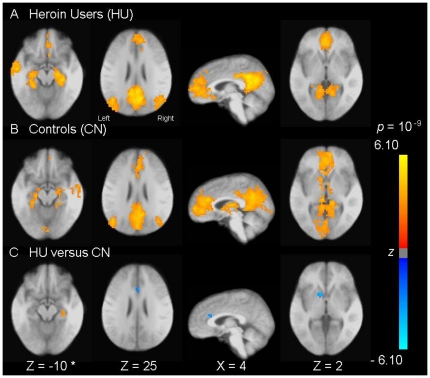
Altered Functional Connectivity of the Default-Mode Network in Heroin Users.Images of group default-mode functional connectivity in heroin users (HU; A) and in non-addicted controls (CN; B). The contrast map in panel C demonstrates clusters (see Table 1) where resting-state functional connectivity in the DMN was altered in HU versus CN. Clusters above thresholds (p<0.05, corrected) in t-tests were lightened with z-scores converted from t-scores of these tests. The z-score bar is shown right side of the figures. The left side of these axial images corresponds to the left side of the brain. * Coordinates in Talairach space (Z, Inferior to Superior, X, Left to Right). For display purposes, a single, averaged, skull striped, stereotaxic transformed image was derived from 27 three-dimensional structural scans taken from all participants of both groups and statistical maps were superimposed on this structural image.